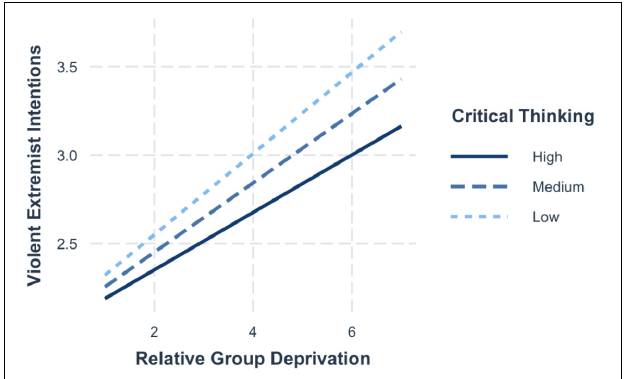
FIGURE 9 | Simple slopes for group deprivation and critical thinking on violent extremist